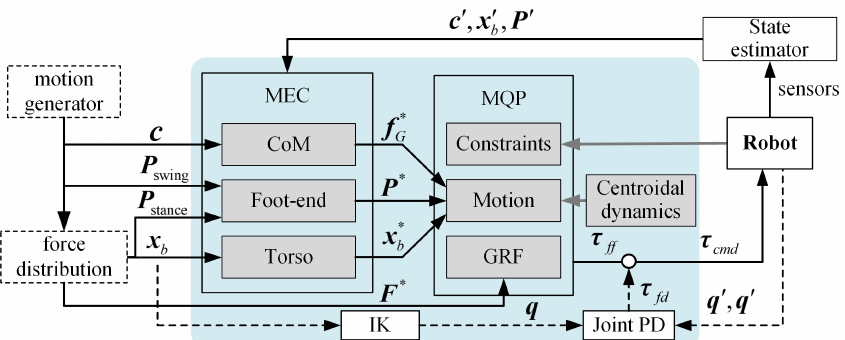
Figure 4. Optimal joint torque control scheme for quadruped robots.